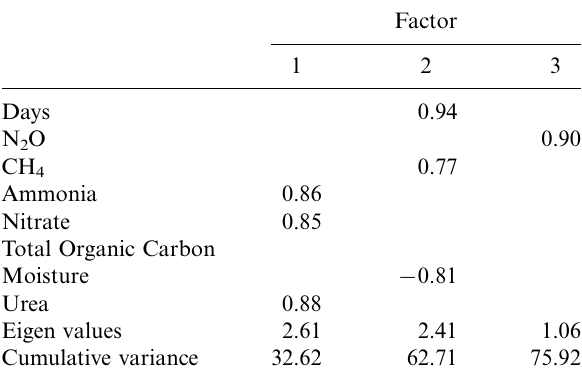
Table 5. Principal component analysis